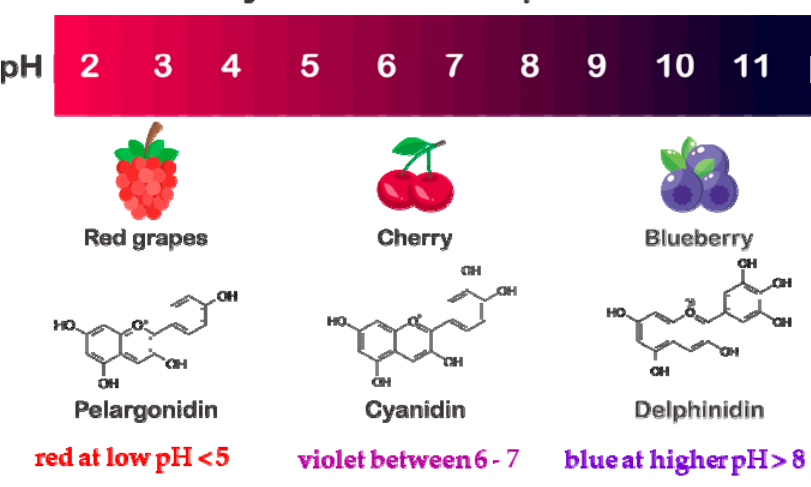
Figure 5. Impact on the coloration of anthocyanins derivatives at different pH.